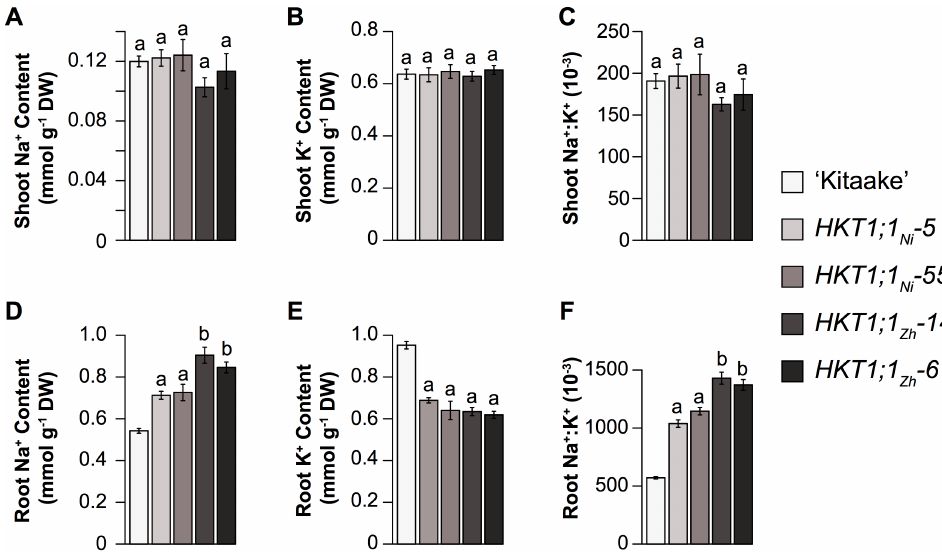
Fig 7. Shoot (A-C) and root (D-F) ion content for HKT1;1 native overexpression lines. Statistical significancewas determinedusing Tukey’s HSD test betweeneach line within treatments. Bars with the same letters indicateno significantdifference ( p < 0.05). Error bars represent standard error of the mean where n = 12–18 plants.